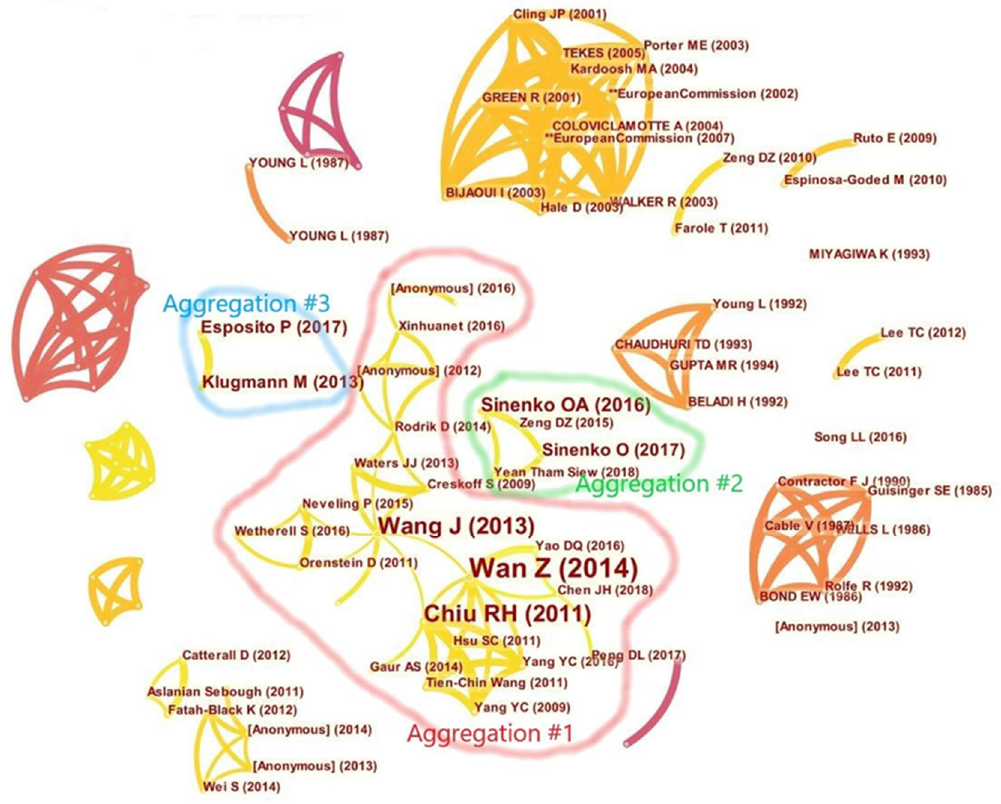
Figure 9. Co-citation network of FTZ. (Note: Figure 9 is generated by the authors using CiteSpace, which is a free software that has been authorized for academic uses (see http://cluster.cis.drexel.edu/~cchen/citespace/, accessed on 21 April 2022)).